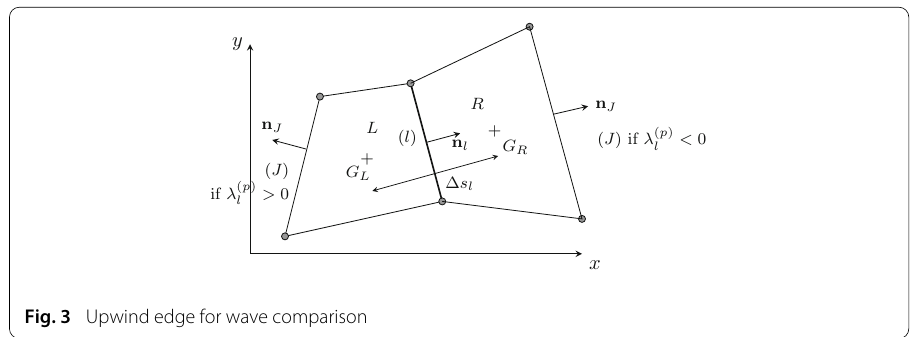
Fig. 3 Upwind edge for wave